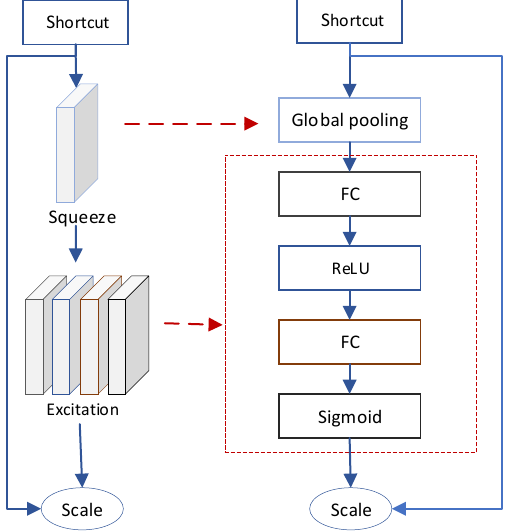
Figure 3. SENet structure. FC, Fully Connected